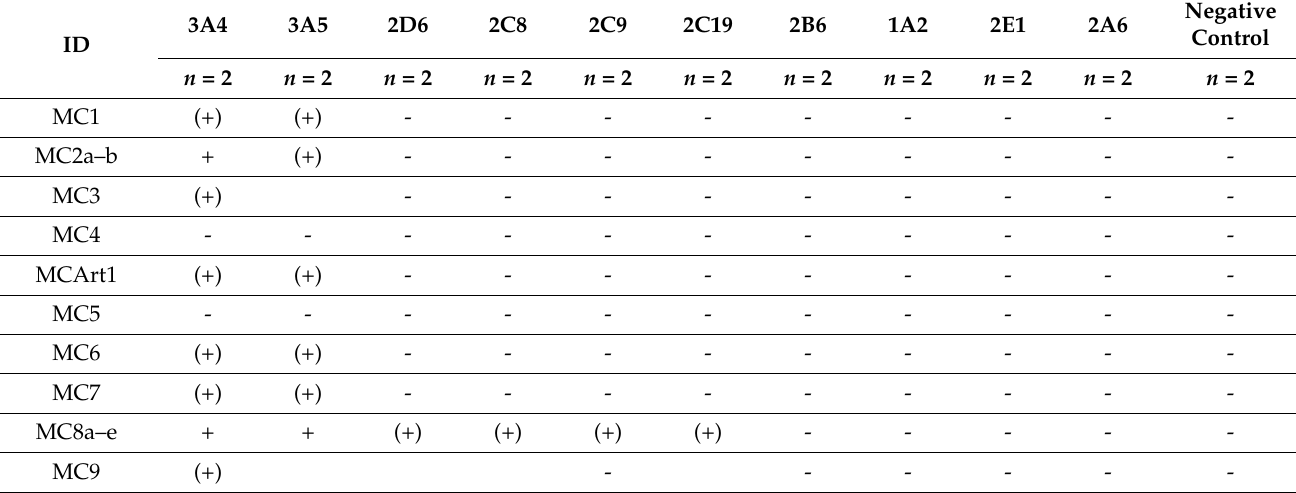
Table 2. Results of the incubation of CUMYL-THPINACA with rCYP. Listed area ratios (absolute peak are (metabo- lite)/absolute peak area (ISTD)) are classified as follows: (+): <0.1, +: ≥ 0.1– ≤ 1, ++: >1– ≤ 5, +++: >. Where the negative control contained trace amounts of metabolites in a comparable amount, as in the samples after incubation, the result is marked as: (+)